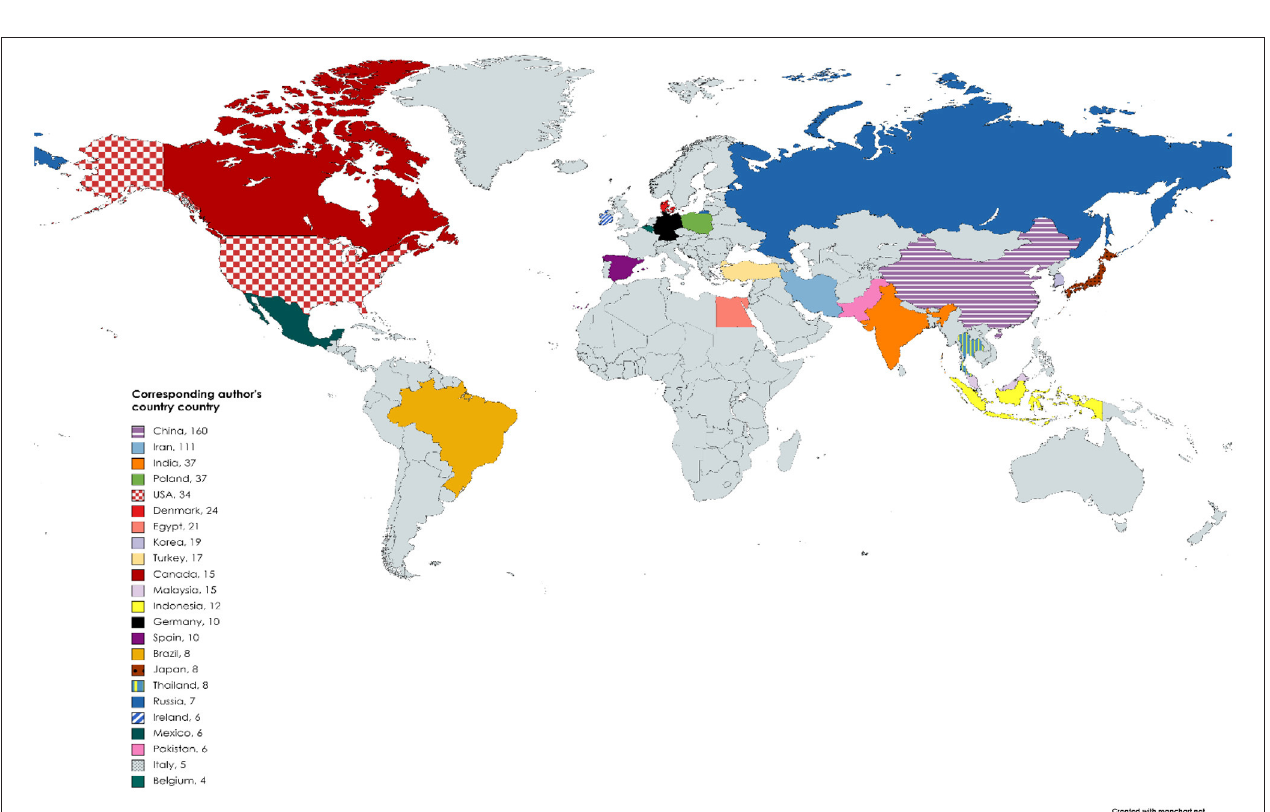
Frontiers in Research Metrics and Analytics |